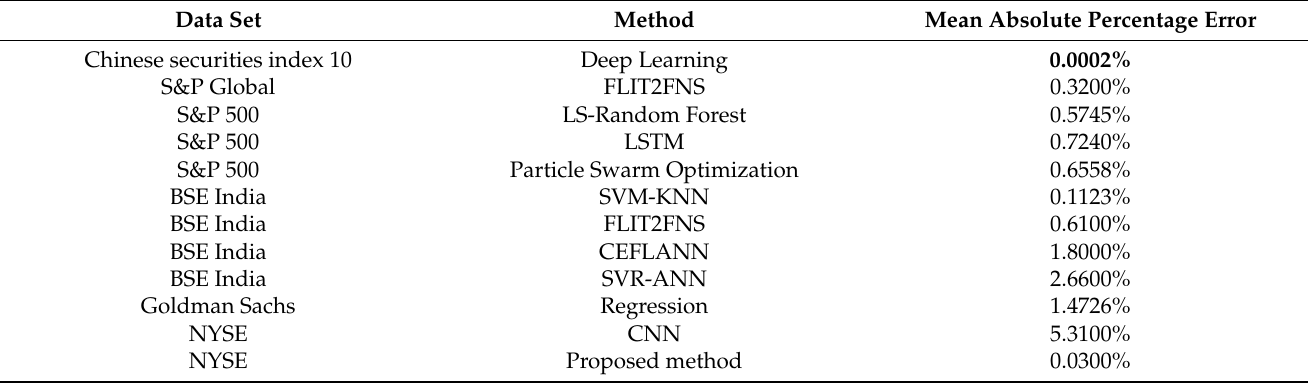
Table 8. Results of the proposed method against published results of prediction